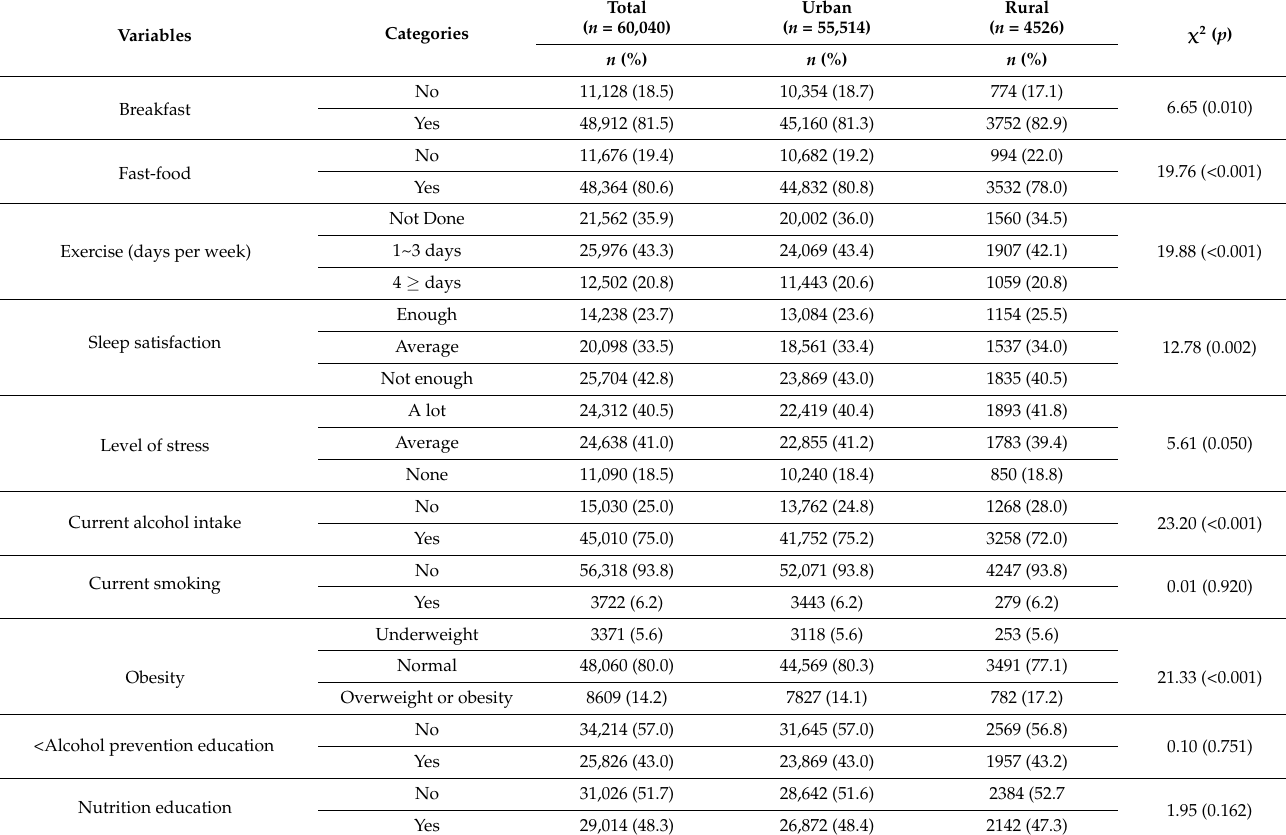
Table 4. Comparison of health behaviors and health education among urban and rural